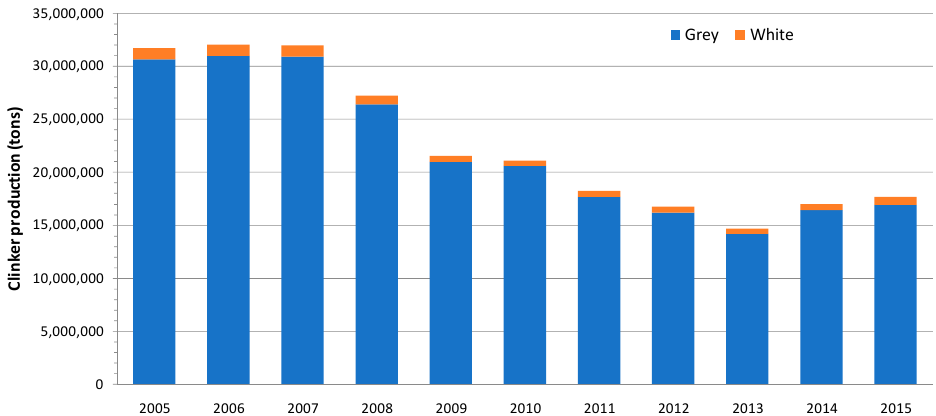
Figure 10. Absolute CO 2 emissions (tons) evolution from 2005 to 2015 for the Spanish clinker production: process emissions (bars in blue); fuel emissions (bars in orange).